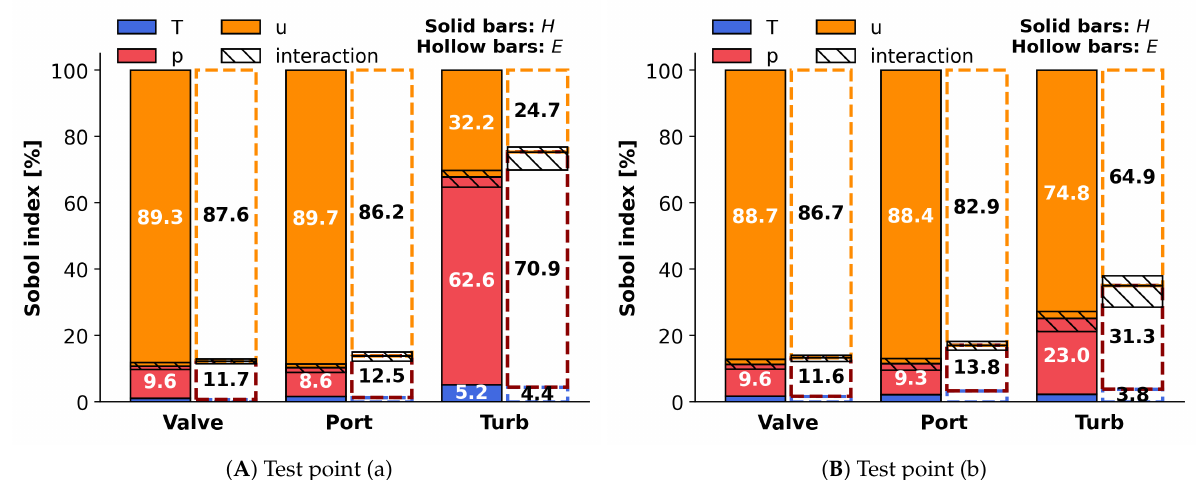
Figure 15. The significance of flow parameters on enthalpy and exergy rates at the tested operating points. The solid bars represent enthalpy, and the hollow bars are for